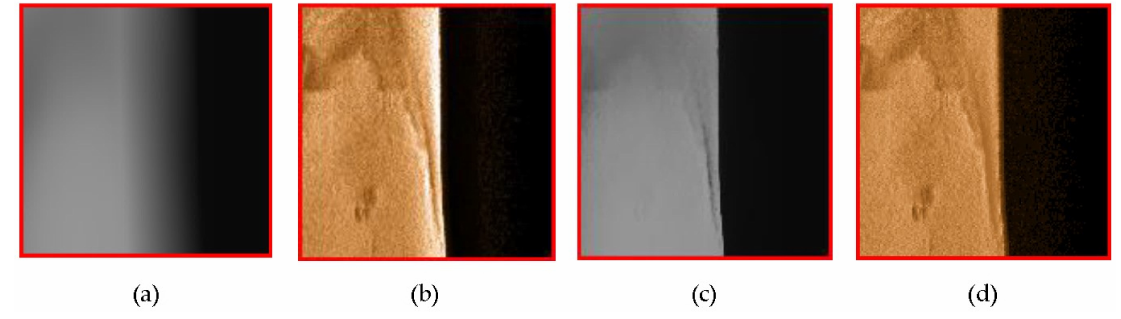
Figure 8. Comparison of experimental details: ( a ) smoothed image using mean filter, ( b ) mean method results, ( c ) smoothed image using bilateral filter, and ( d ) bilateral method results.